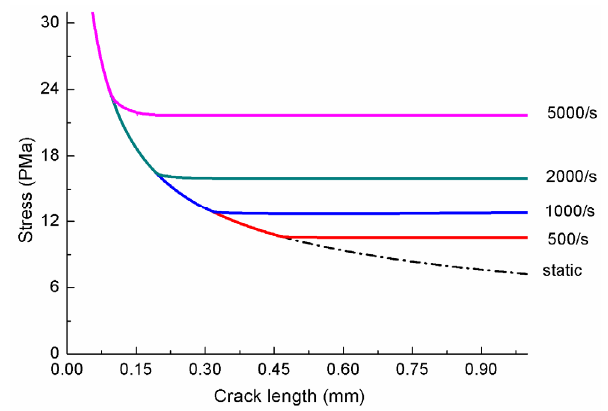
Figure 5. Fracture stress vs. crack size at constant strain-rate loading.